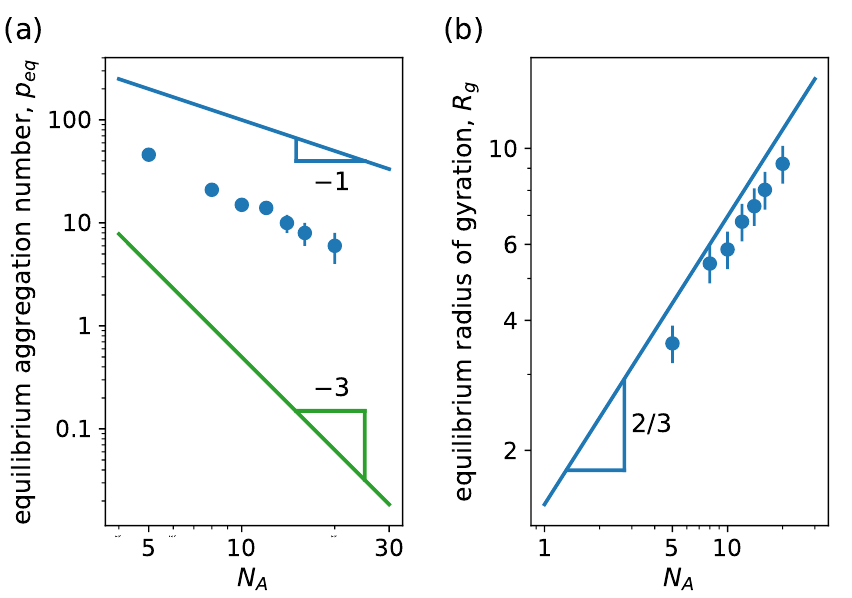
Figure 7. ( a ) Equilibrium aggregation number and ( b ) equilibrium radius of gyration versus degree of polymerization of the hydrophilic block N A . We consider linear charged block copolymers ( g = 0) with N B = 5. Lines correspond to scaling behavior predictions from scaling theory [42]. Blue lines correspond to the limit of small aggregation number, where p (cid:28) α − 1/2 λ − 1 line corresponds to the limit of large aggregation number, where p (cid:29) α − 1/2 λ − 1 parameters: w c = 2.5, (cid:101) attr = 1.0, k B T = 1.0, Z A = N A and Z B = 0.